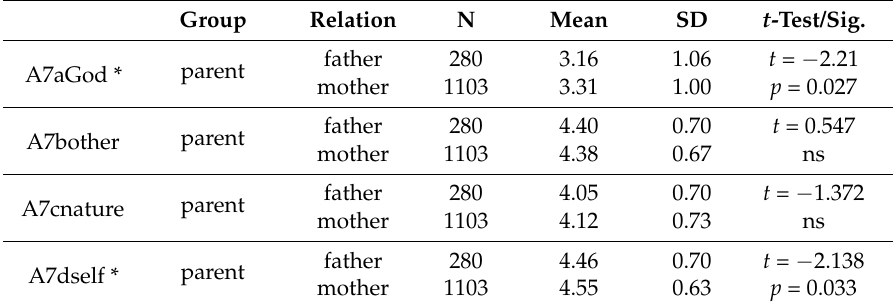
Table 1. Comparison of parental means for ‘spiritual well-being’ (SWB) items and as a whole. Group Relation N Mean SD t